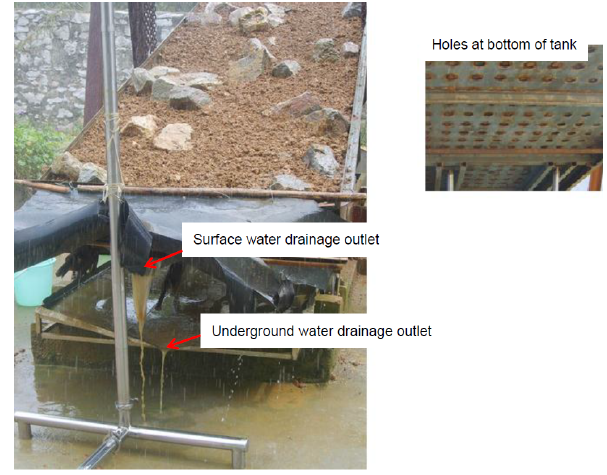
Figure 2. Image of steel